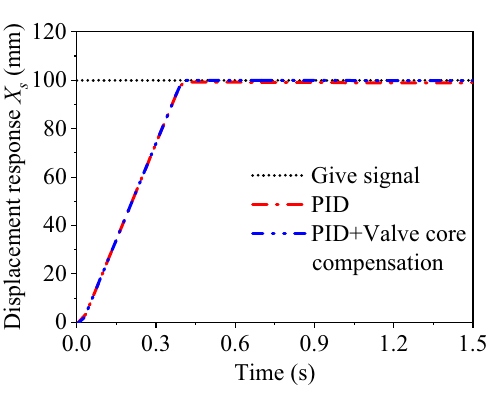
Figure 9. Displacement response comparison of manipulator